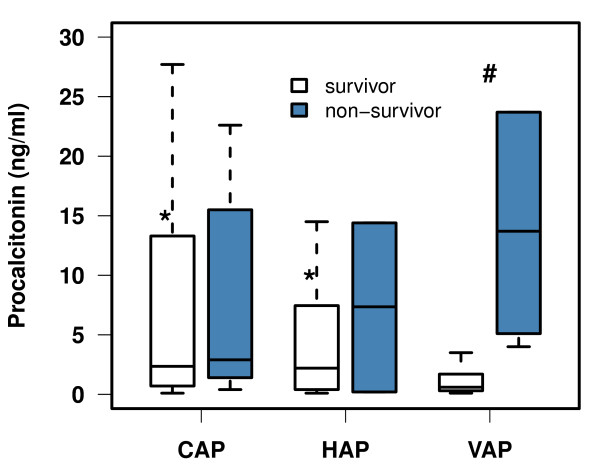
Initial PCT-values for CAP, HAP, and VAP separated for survivors and non-survivors. *: P < 0.05 (survivors vs. non-survivors), #: P < 0.05 (Bonferroni corrected) compared to VAP.